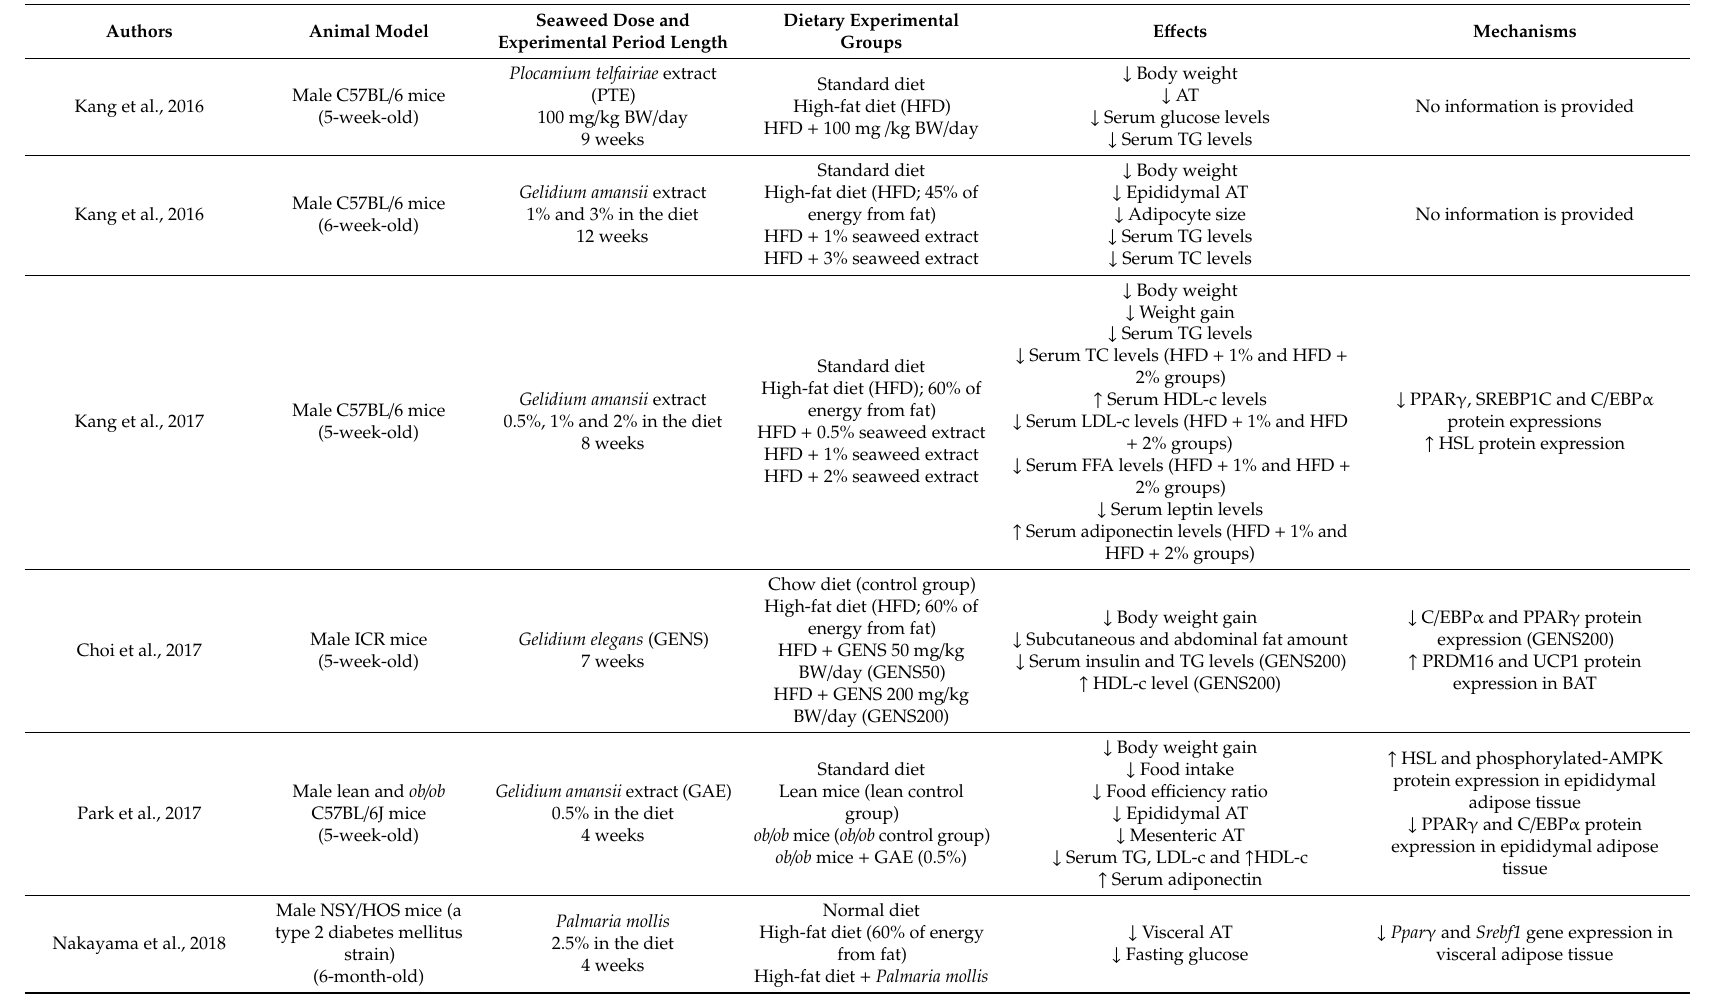
Table 3. In vivo e ff ects of red seaweeds in di ff erent animal